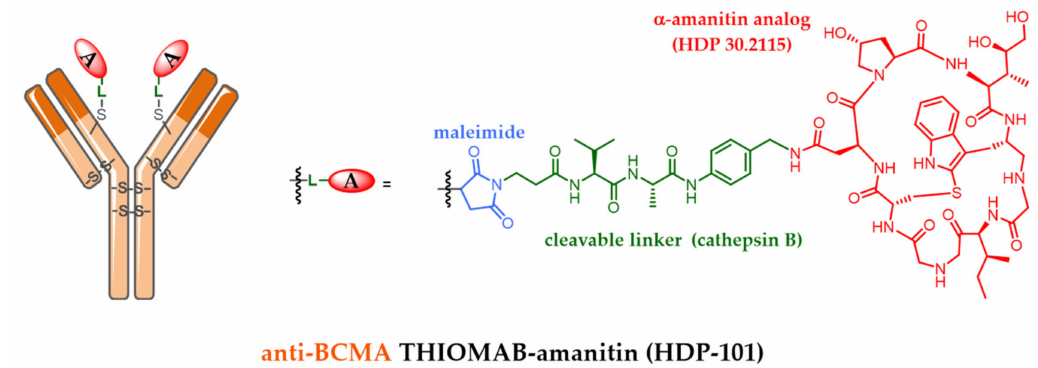
Figure 11. HDP-101 formula, ADC with a DAR 2, resulting from the site-specific conjugation of an α -amanitin analog (HDP 30.2115) onto an anti-BCMA Thiomab via a cathepsine B-sensitive linker.